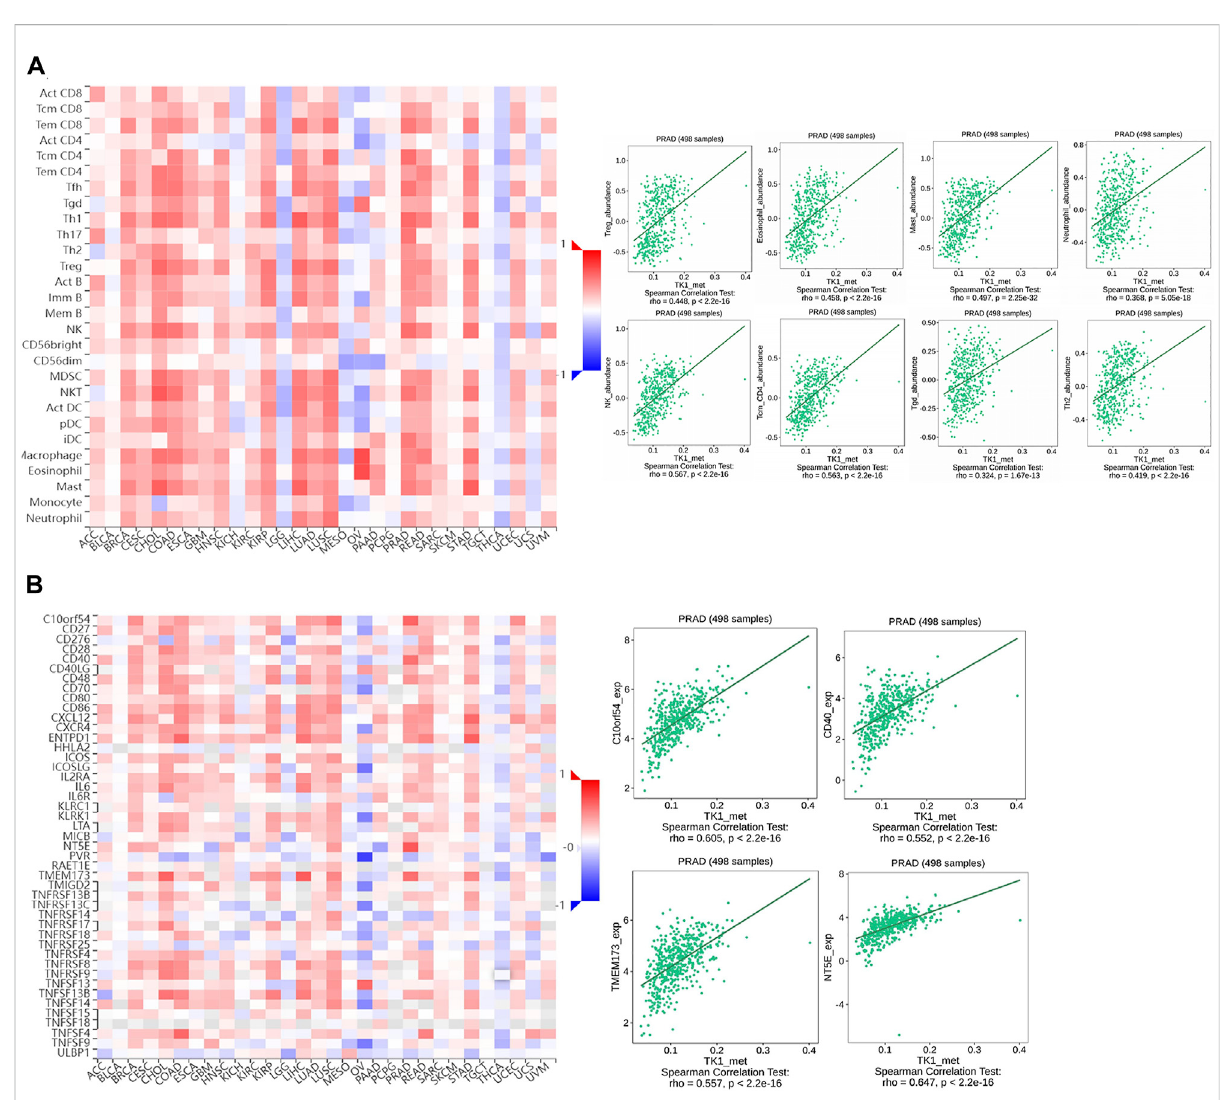
FIGURE 8 TherelationshipofthemethylationstatusofTK1withimmunein fi ltrationinPCa. (A) RelationshipofthemethylationstatusofTK1withTh2cells, Tregs, NK eosinophils, NK cells, neutrophils, Tcm, and Tgd in PCa available from the TISIDB data resource. (B) Relationship of the methylation status of TK1 with immunostimulator PCa available from the TISIDB data